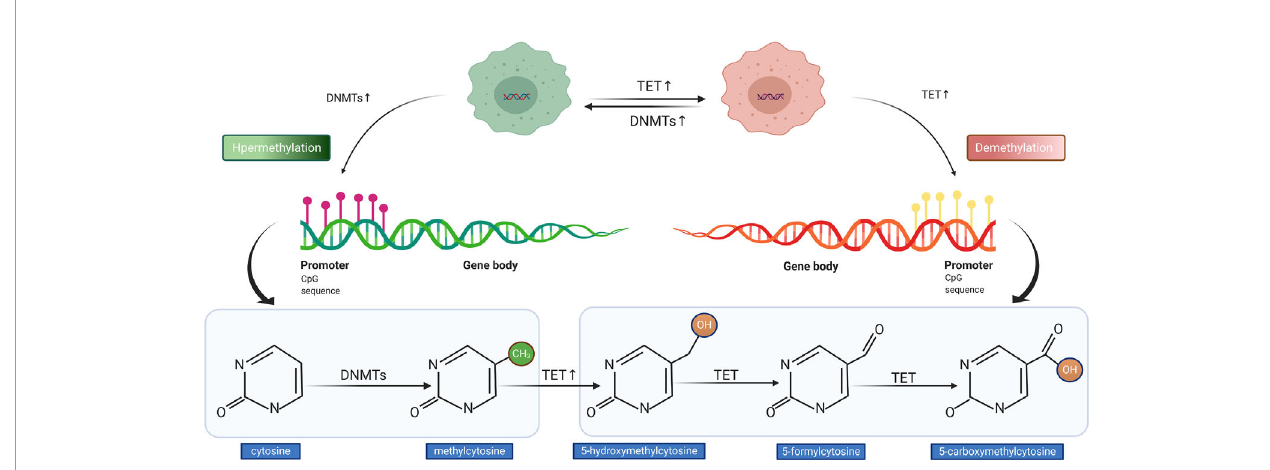
FIGURE 3 | Illustration of DNA hypermethylation and demethylation patterns. The DNA methyltransferase (DNMT) mediates the hypermethylation of DNA promoter (left). The ten-eleven translocation (TET) enzyme conducts the demethylation of DNA promoter